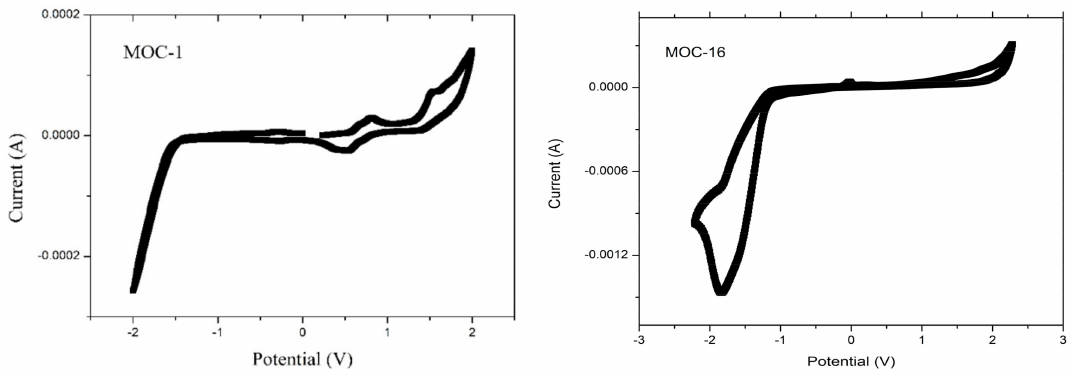
Figure 2. Cyclic voltammograms (50 mV s − 1 ) for CZ-2, CZ-1, MOC-1 and MOC-16 compounds.